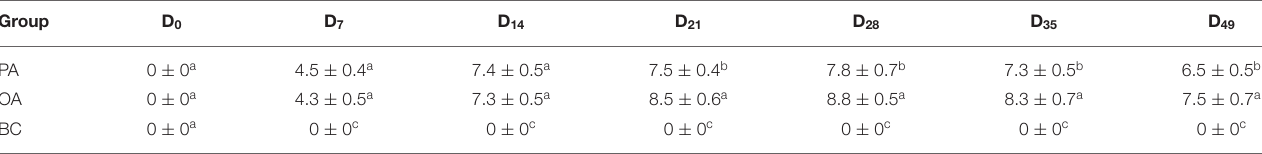
a − c Data within a column without the same superscripts differ significantly (p < 0.05).